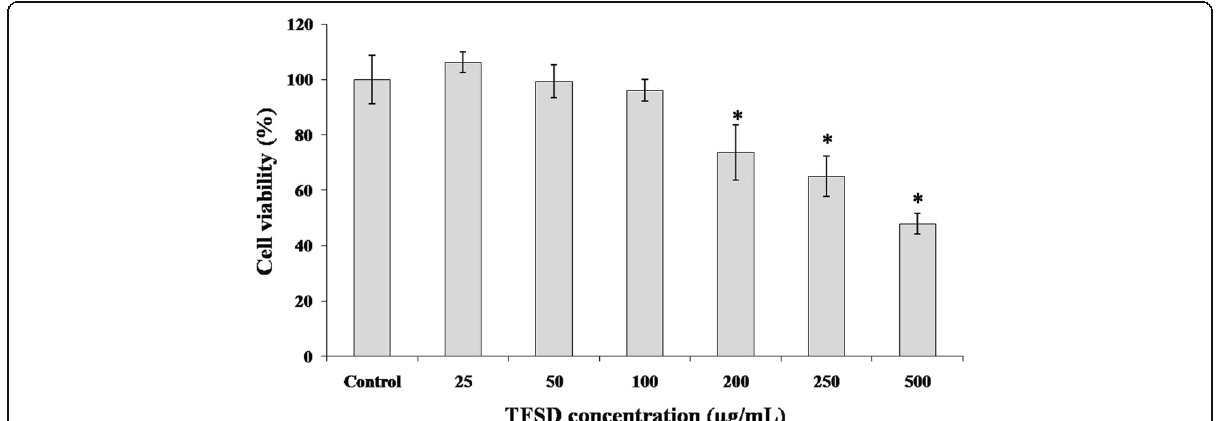
Fig. 1 Viability of RAW264.7 cells after treating with various concentrations of TFSD for 48 h. Data are presented as mean ± S.D. Bars with * indicate statistically different from control ( P < 0.05)